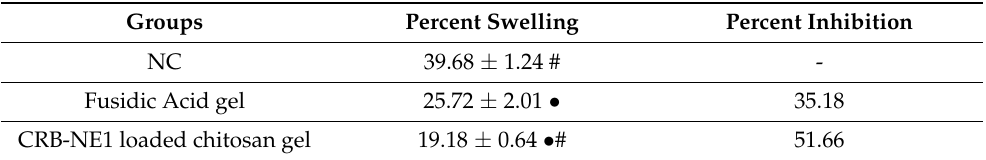
Figure 9. Comparative mean paw swelling by fusidic acid gel and CRB-NE1 loaded chitosan. gel on carrageenan-induced paw edema. Table 3. Anti-inflammatory activity of the CRB-NE1-loaded chitosan gel on carrageenan-induced paw edema.